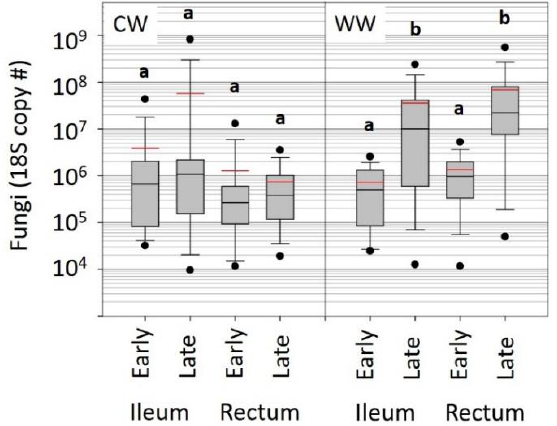
Figure 3. Box and whisker plots representing the total fungal abundance associated with cold winter (CW) and warm winter (WW) ileum and rectum tissues. Overwinter is depicted by early and late winter samples. Box and whiskers represent 25–75% and 5–95% percent of the distribution, respectively. The y-axis is a logarithmic scale (Log10). Different letters indicate significant differences. Two of the bacterial groups that increased significantly in late winter WW samples were strongly and positively correlated with increasing fungal abundance across the assessed time period (Figure 4, Gilliamella spp.: Rsq = 0.64, p < 0.0001, and Enterobacteriales: Rsq = 0.50, p <